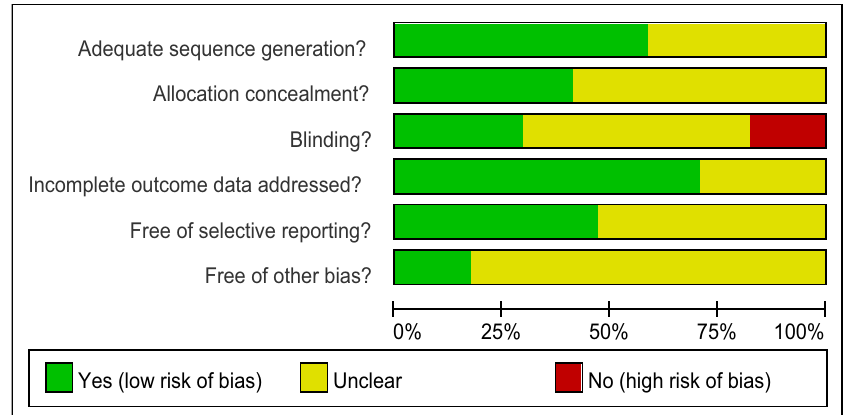
Figure 2: The general assessment of the included 17 clinical